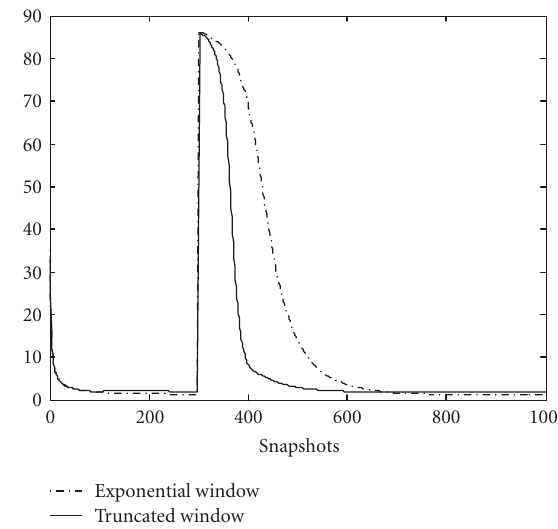
Figure 13: Maximum principal angle of the fast CPAST algorithm with exponential and truncated